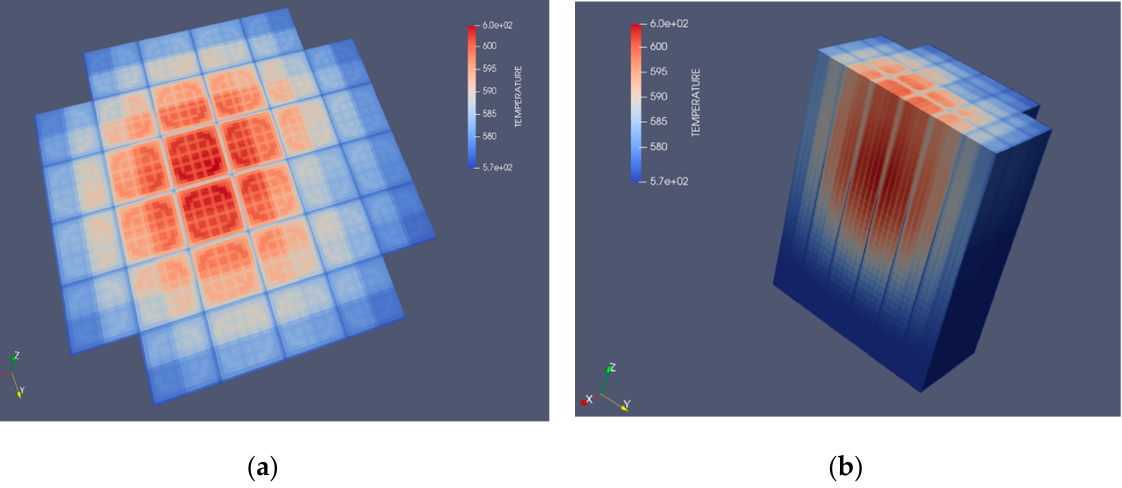
Figure 10. Coolant temperature distribution under pin-by-pin discretization: ( a ) The 2D distribution; 2D Coolant Temperature Distribution; ( b ) 3D distribution; 3D Coolant Temperature Distribution.